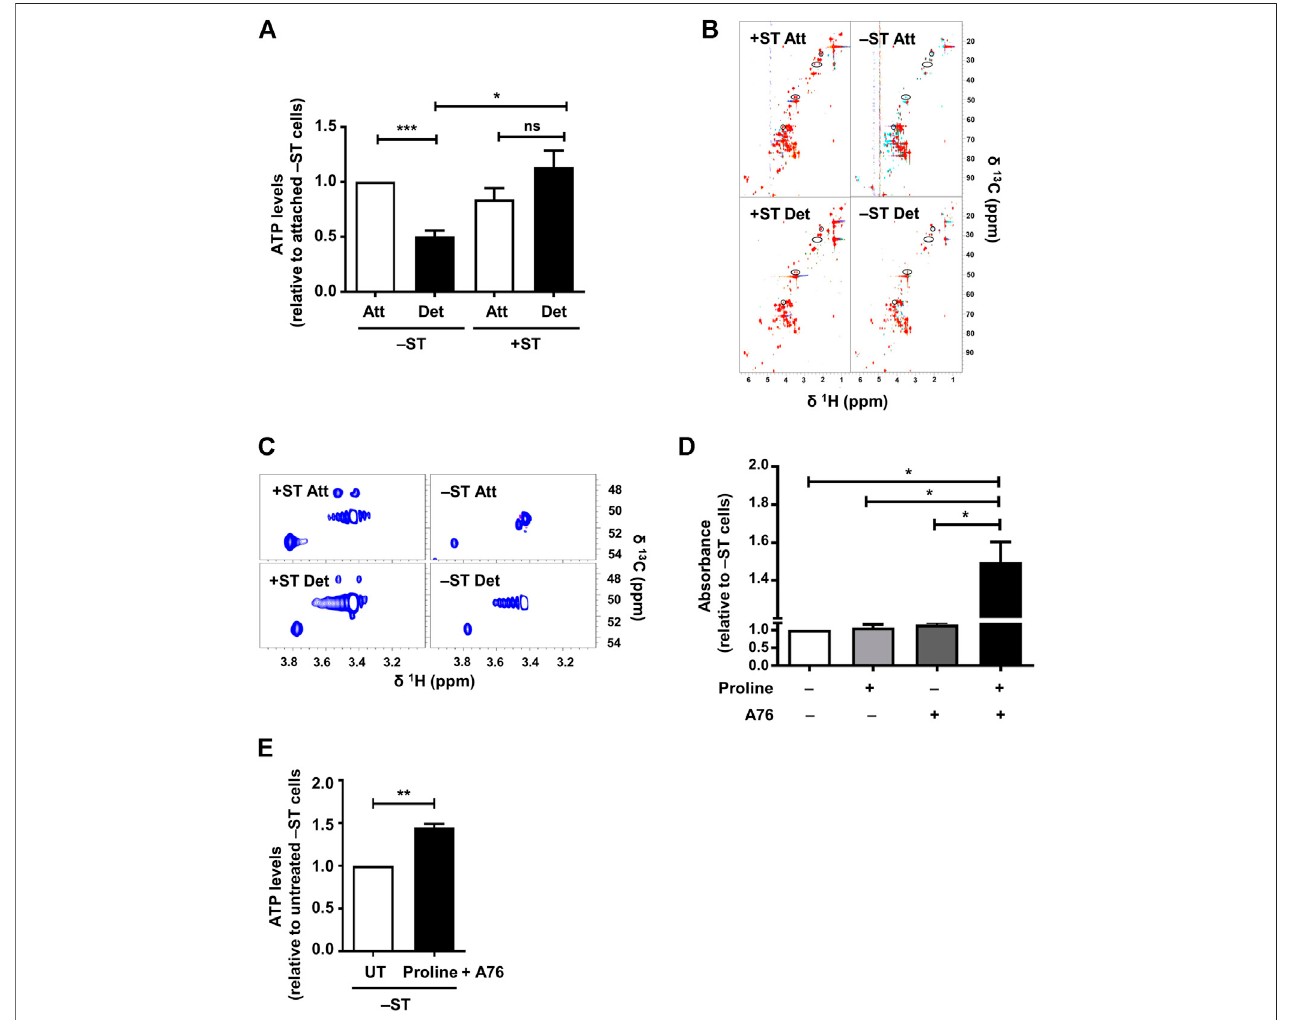
FIGURE3| ProlinesupplementationincombinationwithAMPKactivationincreasesATPlevelsandenhancessurvivalof − STcells: (A) – STand+STcellssubjected to conditions of attachment (Att) and detachment (Det), were harvested for the measurement of ATP levels. Graph represents ATP levels; n (cid:1) 5. Error bars represent mean ± SEM. (B,C) − ST and +ST cells subjected to conditions of attachment (Att) and detachment (Det), were harvested for 2D [ 13 C, 1 H] HSQC NMR spectra. (B) The spectra from 5 biological repeats are overlaid. Peaks present in +ST cells but absent in − ST cells are circled. (C) Spectra shows zoomed-in region of two such peaksexclusivelypresentin+STcells. (D) − STcellswerecultured ina96-wellultra-lowattachmentplateinthepresenceofproline(200 mg/L;w/v)andAMPKactivator, A-769662(A76;150 μ M),eithersinglyorincombinationandsubsequentlyMTTassaywasperformed.Absorbancewasmonitoredafter48 h; n (cid:1) 4.Errorbarsrepresent mean ± SEM. (E) – ST cells subjected to matrix-deprived conditions for 48 h in the presence of proline (200 mg/L) and AMPK activator A-769662 (A76; 150 μ M) were harvested for measurement of ATP levels. Graph represents ATP levels; n (cid:1) 4. Error bars represent mean ± SEM.